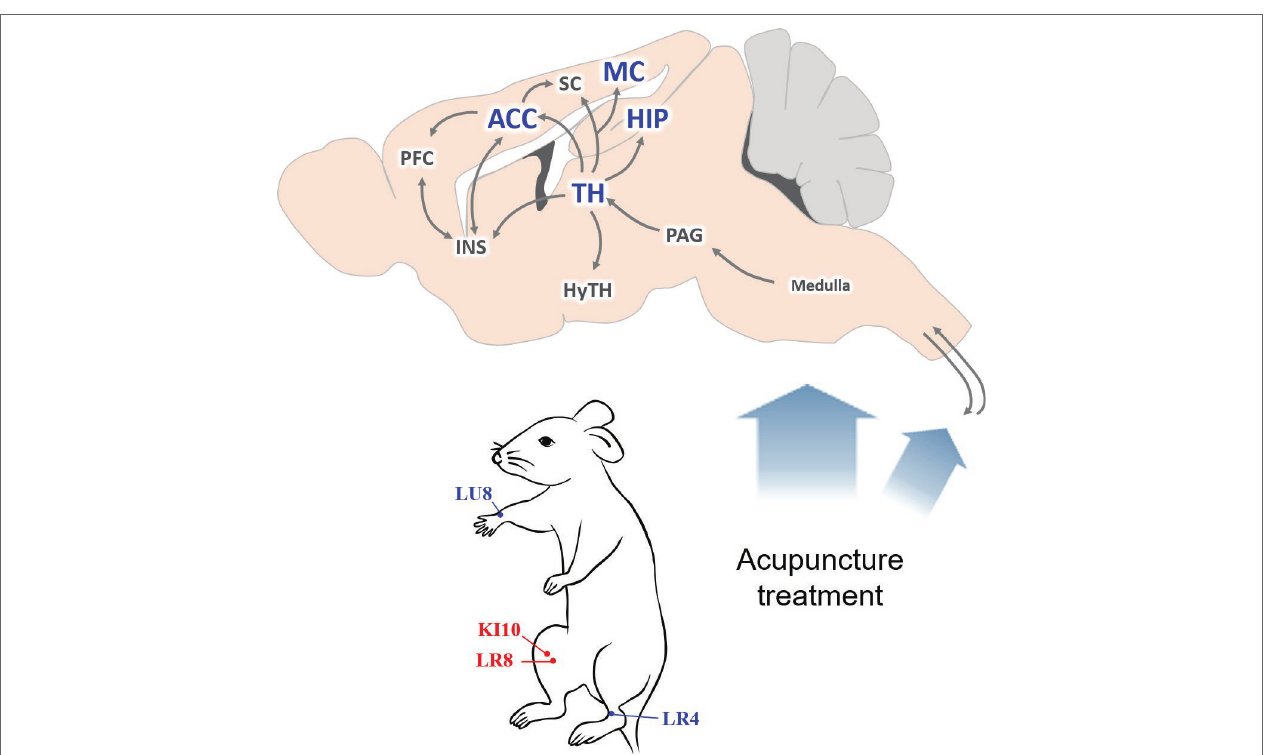
FIGURE 8 | Schematic diagram of the neural mechanism by which acupuncture at AP (KI10·LR8·LU8·LR4) affects depressive-like behavior. A proposed central neural mechanism by which effects of acupuncture needling are exerted. Acupuncture-induced signaling are received by the peripheral nerve endings and are then transmitted to the afferent sensory nervous tract. Brain regions, such as the thalamus, hippocampus, motor cortex, and anterior cingulate cortex are involved in acupuncture-mediated central signals. ACC, anterior cingulate cortex; HIP, hippocampus; HyTH, hypothalamus; INS, insular cortex; MC, motor cortex; PAG, periaqueductal gray; PFC, prefrontal cortex; SC, somatosensory cortex; TH,